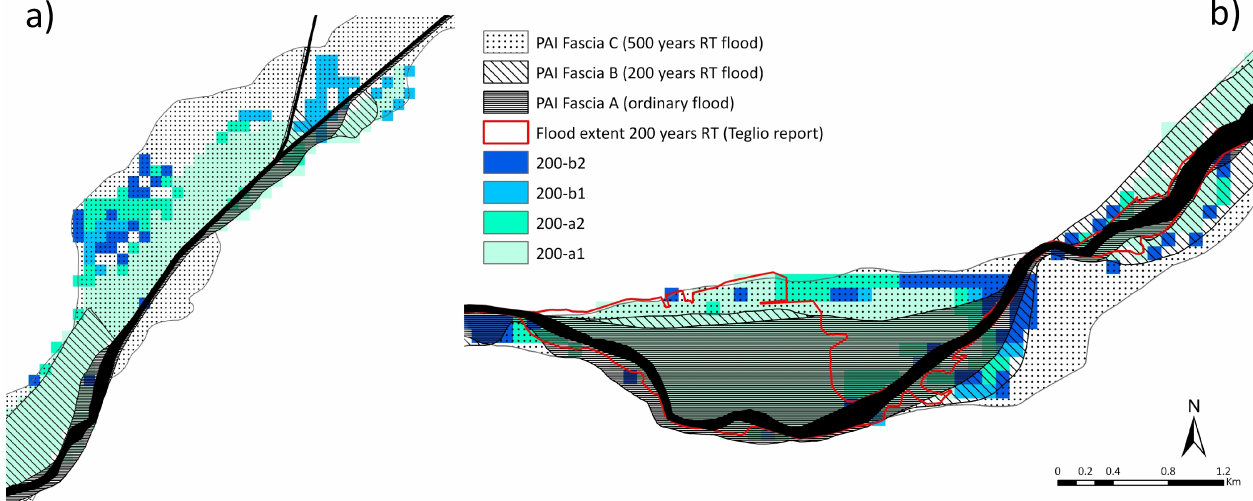
Fig. 4. Visual comparison among modelling results, available hydraulic reports, and PAI Fasce Fluviali in Tirano (a) and Teglio (b) , for the 200years RT